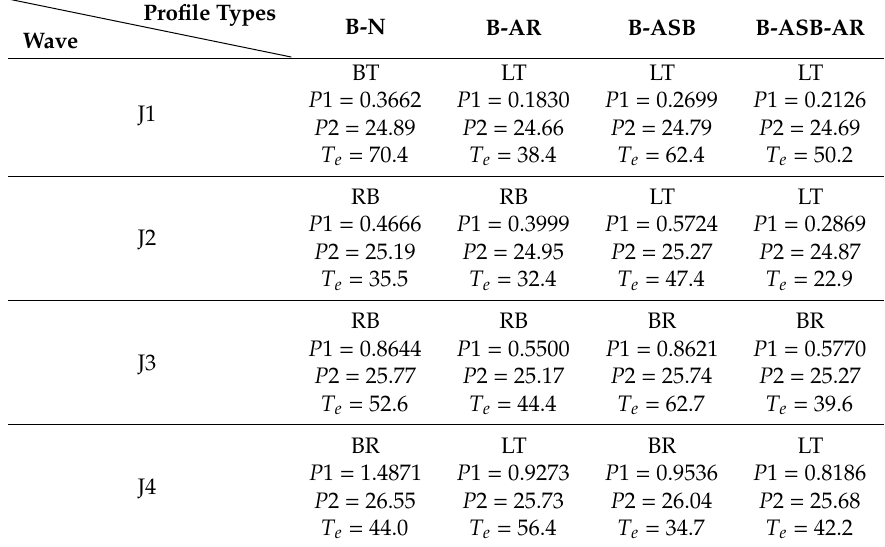
Table 7. Fitting parameters of the scarp model and corresponding beach state for each test. Profile Types Wave